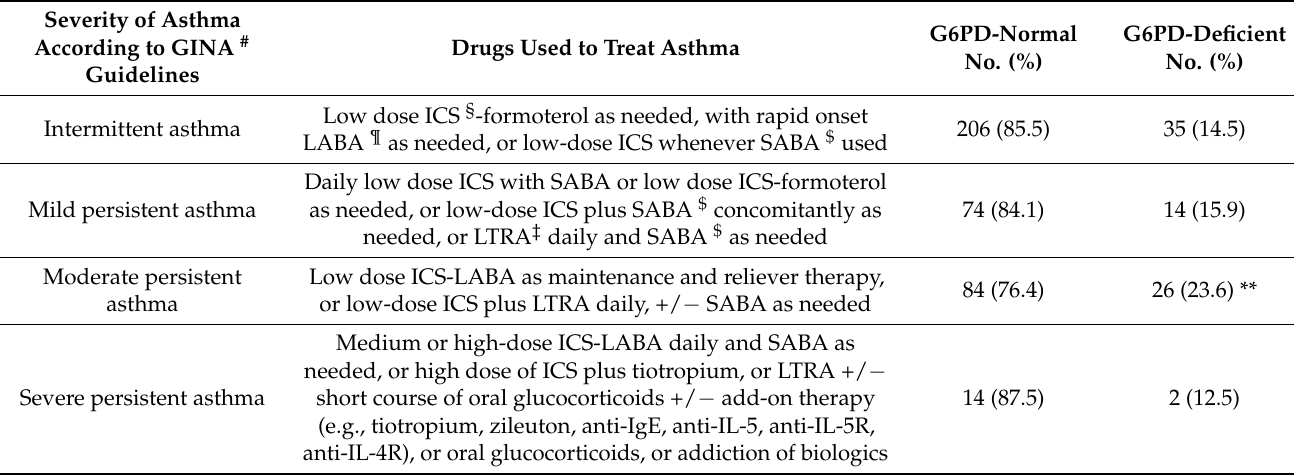
Table 4. The severity of asthma based on the Global Initiative for Asthma (GINA) classification according to glucose-6- phosphate dehydrogenase (G6PD)